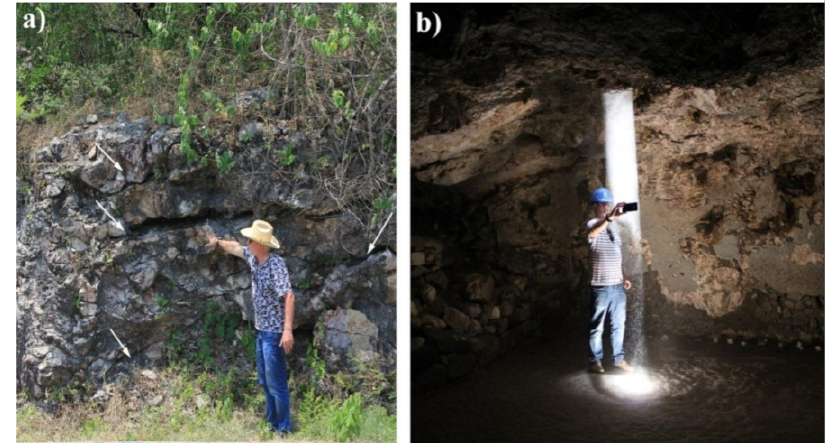
Figure 1. ( a ) Stratification planes, joints, and fractures enlarged by the hydrochemical dissolution process; ( b ) cave with anthropic modifications in the ceiling for astronomical